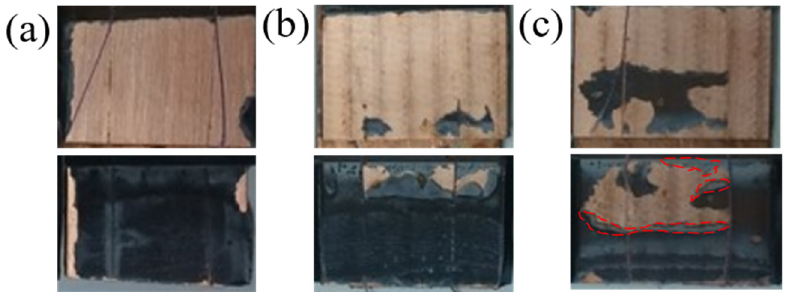
Figure 12. Selected photographs of the overlapping bonding area after single-lap shear testing. Each top and bottom pair of images correspond to the same bonded specimen: ( a ) A2 baseline specimen; mixed failure, ( b ) C3 (12 mm/s) adhesive failure; and ( c ) C4 (12 mm/s) adhesive failure.